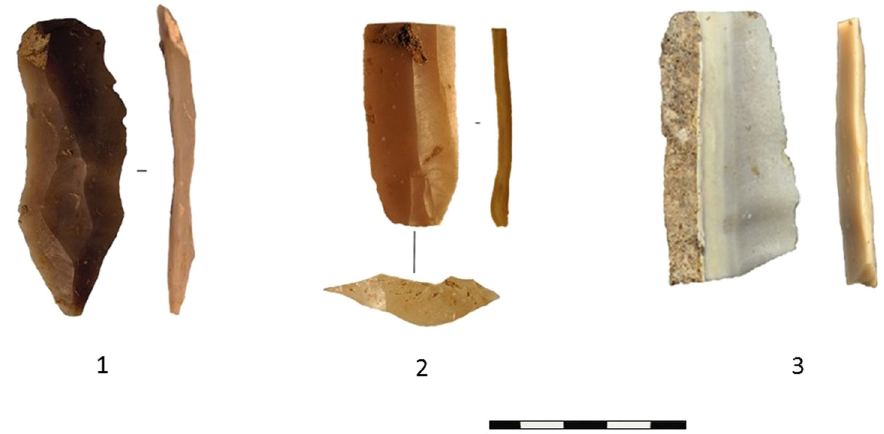
Figure 7: Unused Blades. ( 1 ) Undetermined Blade ( rhythm D ) , obtained by ( lever ) pressure, direct or indirect percussion; ( 2 ) Central Blade ( “ débitage optimum , ” rhythm C2 ) obtained by ( lever ) pressure, the butt is out of scale; ( 3 ) Cortical Blade ( cortex covering single ridge ) , obtained by lever pressure or indirect percussion, pro fi le slightly on “ S, ” wavy dorsal surface, undulations on ventral